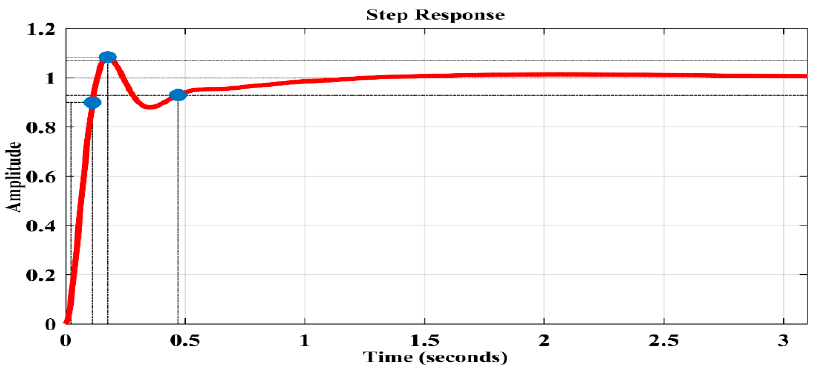
Figure 11. Step response of AVR-based IGBO-FOPID controller.